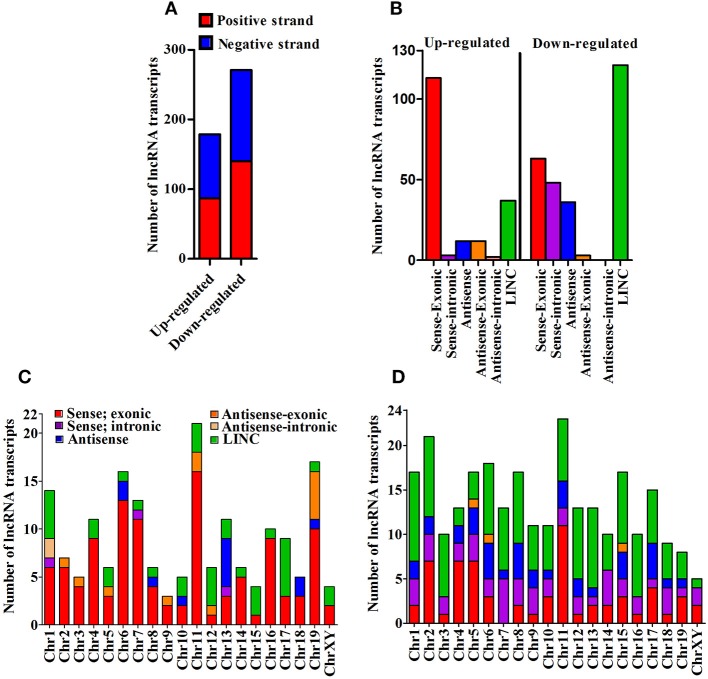
Cataloging of differentially expressed lncRNA transcripts. (A) Strand specific origin of differentially expressed lncRNA transcripts; (B) Cataloging of lncRNA transcripts based on their origin; (C) Chromosomewise distribution of category of up-regulated lncRNA transcripts; and (D) Chromosomewise distribution of category of down-regulated lncRNA transcripts.